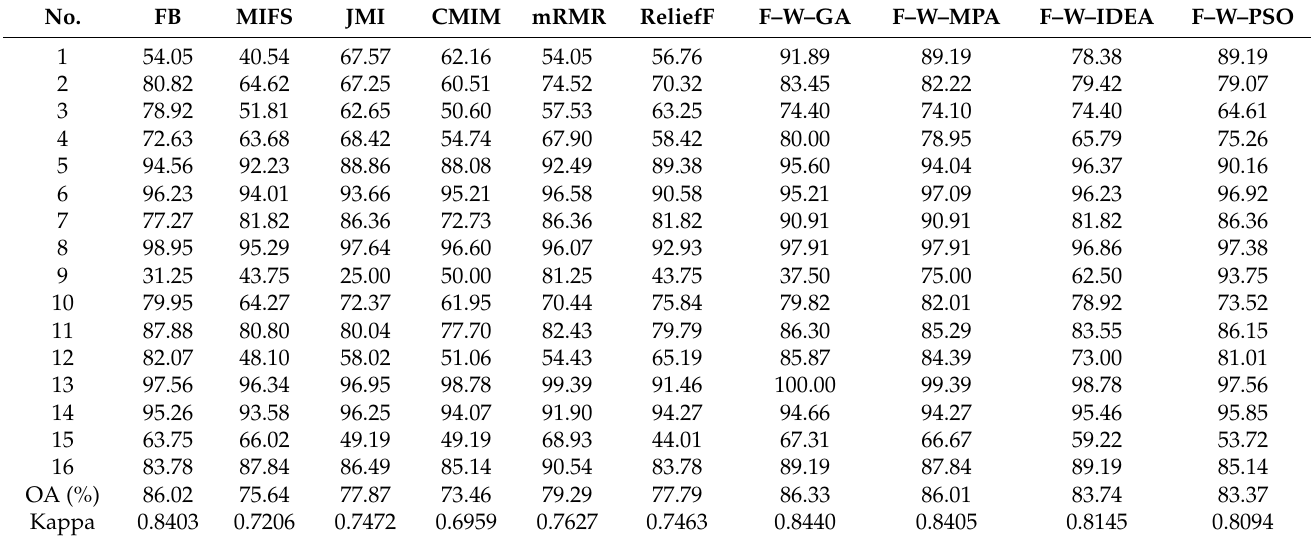
Table 6. The OA, Kappa coefficient, and accuracy of each class for Indian Pines dataset.